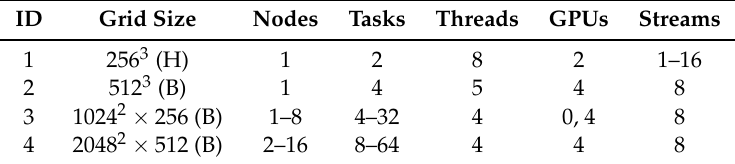
Table 3. Configurations for fiducial runs. Tasks and GPUs (if used) refer to the number per node, threads refers to the number per task, and streams are the number of GPU streams. The “B” designation refers to the Boussinesq equations, Equations (1)–(3), while the “H” refers to the HD equations. All runs were conducted on the SummitDev system in Table 2 and, if stated explicitly, also on the Caldera system. ID Grid Size Nodes